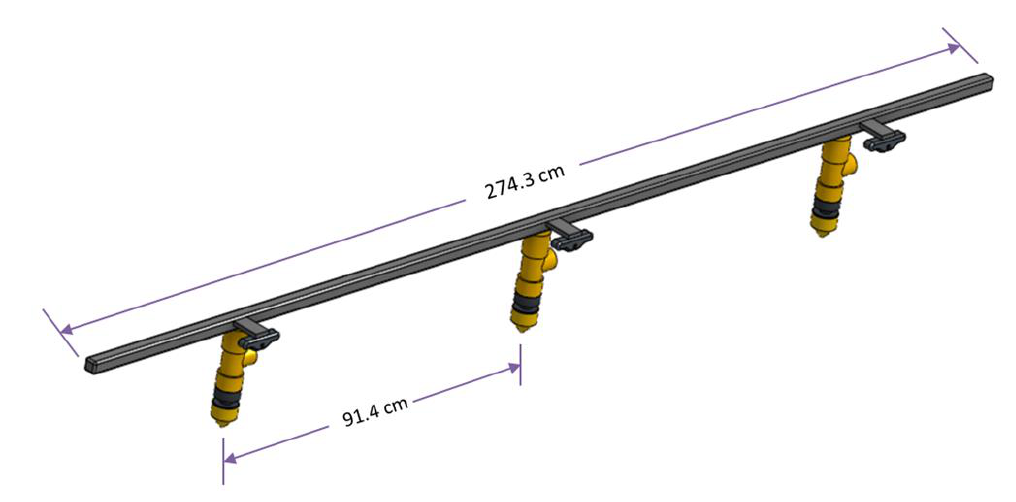
Figure 2. Spraying boom with nozzles and cameras to account for the distance between the two rows of potato plants cultivated in furrows.